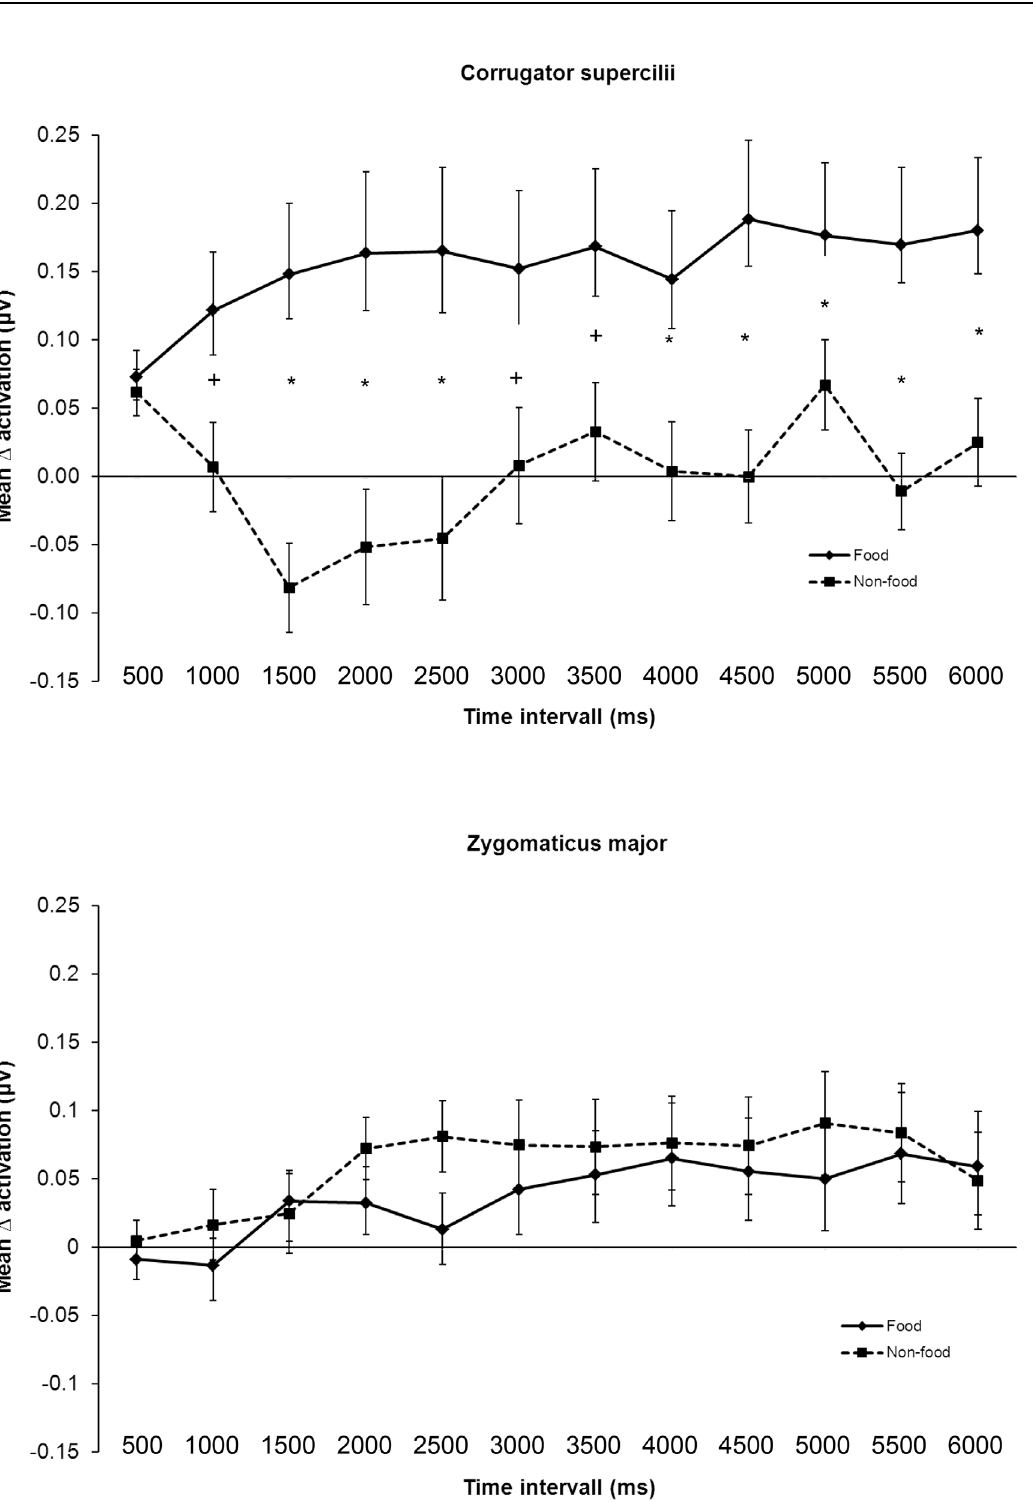
Fig 3. Time course of the mean Δ activation and standard errors for the corrugator supercilii and the zygomaticus major activation over all groups. * indicates significant differences after Bonferroni correction ( p < .004), + indicates significant differences with p -values < .05.